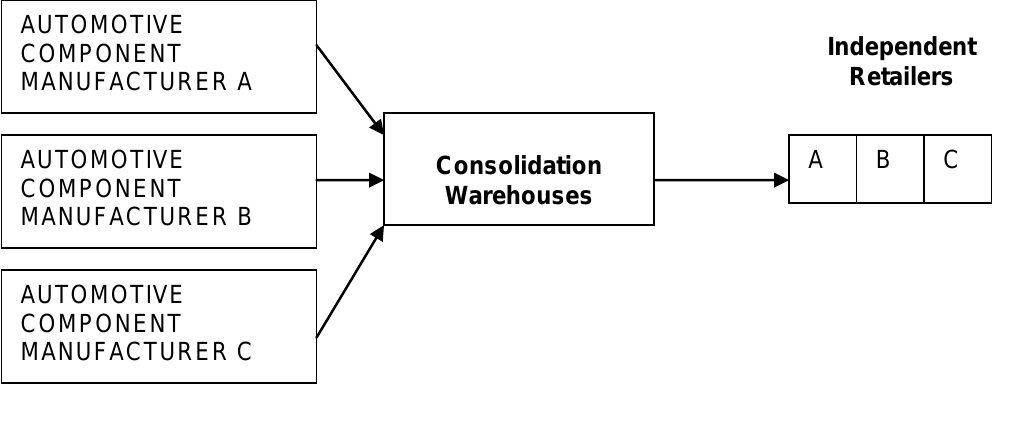
Figure 4 : Consolidation arrangement of “Automotive Component